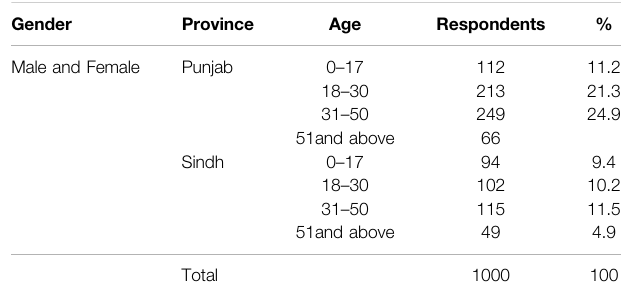
TABLE 4 | Demographics of the respondents.